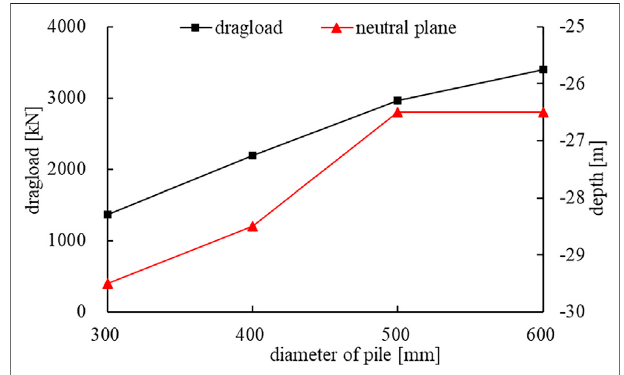
pile. The axial force was greater with a greater pile diameter. Figure 14 represented the change of NSF and the neutral plane